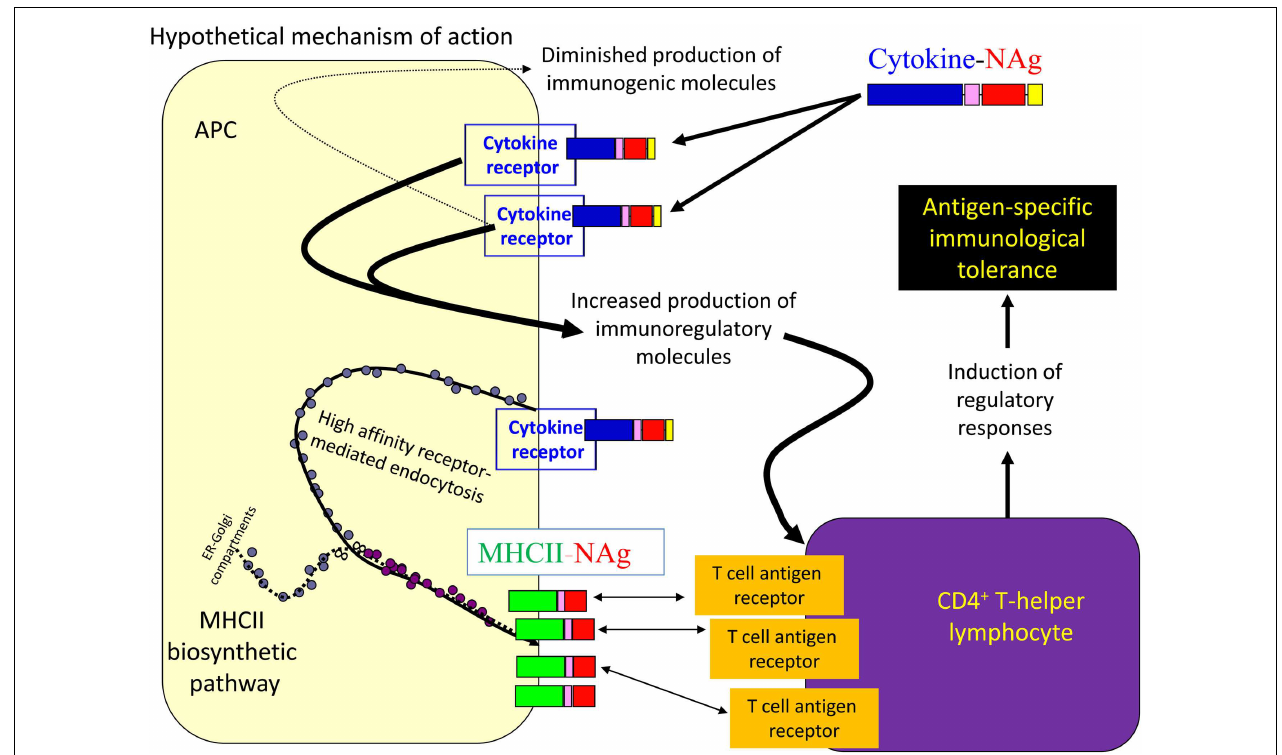
cytokine receptor/vaccine complexes into the endosomal compartment introduces the NAg domain in high concentrations to the MHCII-antigen processing pathway. Processing of the vaccine liberates the NAg domain for loading onto nascent MHCII glycoproteins. By this mechanism, APC that are conditioned by the cytokine domain in turn present high concentrations of NAg domain on MHCII glycoproteins.Tolerogenic presentation of the NAg is postulated to induce regulatory elements and blunt the encephalitogenic immune